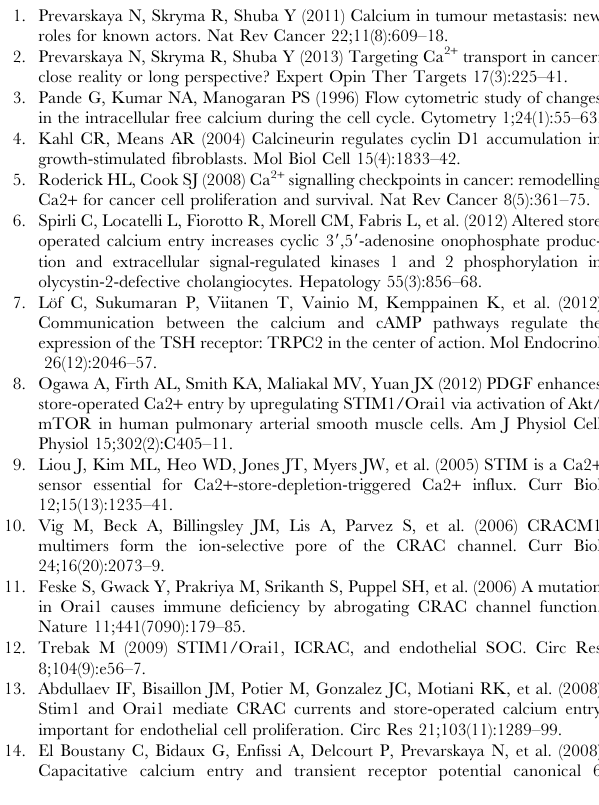
Figure S3 Orai3 channel is functional in NCI-H23 cells and contributes to the basal calcium entry (A). Slope values are: for si-CTL: 2 0.52 6 0.2 (n= 69, 64.4%) and for si- Orai3: 2 0.41 6 0.4 (n= 53, 67.9%). B: Orai3 channel is functional in NCI-H460 cells and contributes to the basal calcium entry. Slope values are: for si-CTL: 2 0.46 6 0.2 (n= 92, 78.6%) and for si-Orai3: 2 0.39 6 0.3 (n= 85, 61.6%). Figure S4 Down-regulation of Orai3 had no effect on cell death of NCI-H23 (A) or NCI-H460 (B). Cells were transfected with si-CTL and si-Orai3. A 24-h treatment with si- Orai3 was without effect on cell viability in both NCI-H23 (C) and NCI-H460 (D), while after 48-h treatment, si-Orai3 significantly reduced the cell number for NCI-H23 (C) and NCI-H460 cells (D). Histogram is representative of three independent experiments and results are expressed as means 6 S.D (t-test).